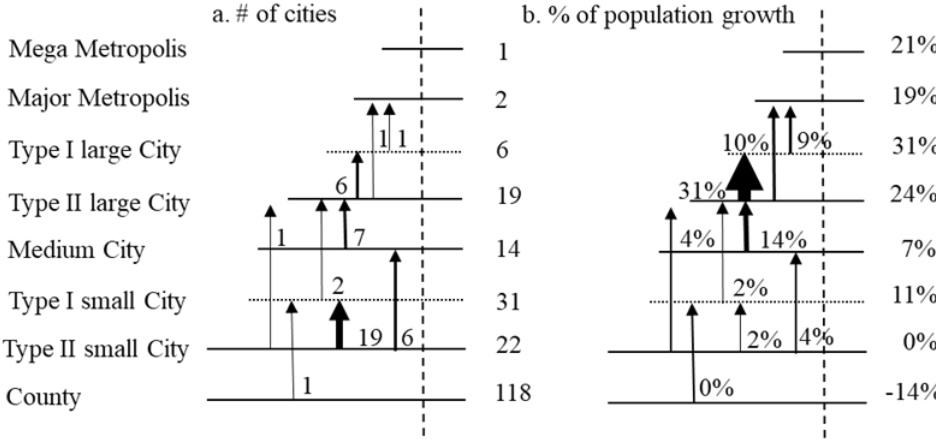
Figure 5. Number of cities and share of cities’ increment to total population growth across hierarchies in 2000–2010.